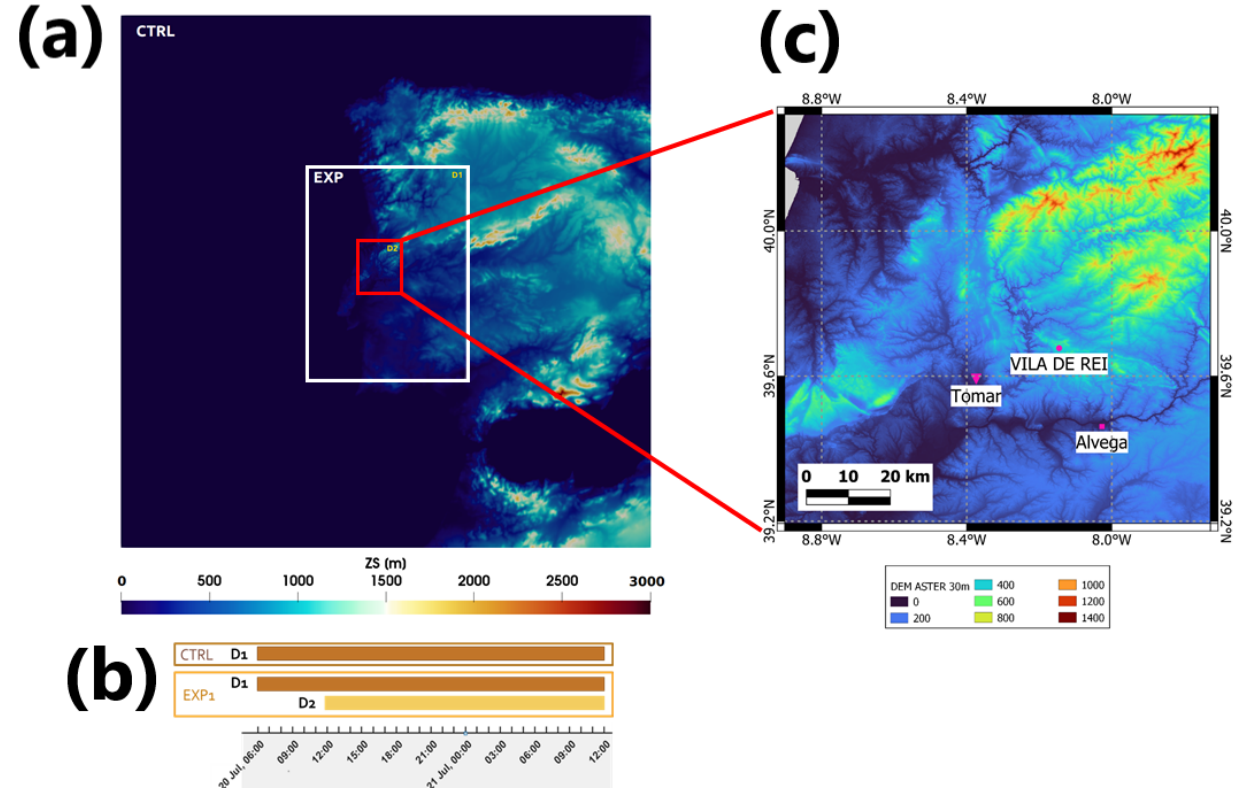
Figure 1. ( a ) Meso-NH configuration and Vila de Rei location with orography obtained from the SRTM database with the large domain at 2500 m resolution (CTRL and EXPD1) and the inner domain at 500 m (EXPD2) resolution; ( b ) Timeline of the period simulated in the larger and inner domains; ( c ) Study Region—Map of local orography from Advanced Spaceborne Thermal Emission and Reflection Radiometer (ASTER), Global Digital Elevation Model (GDEM)—Version 3.